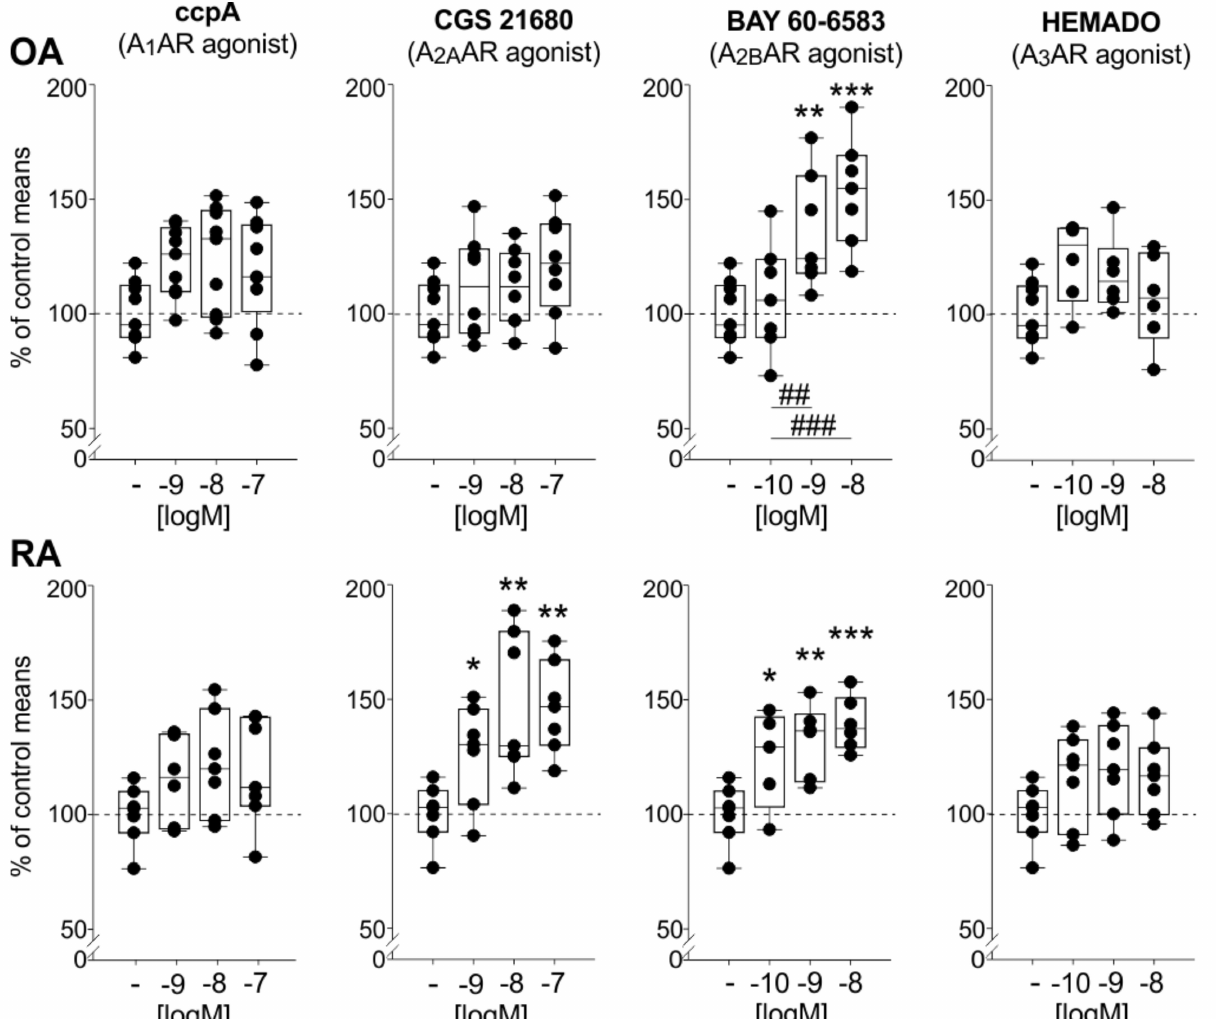
Figure 6. TNF release in OA and RA mixed synoviocyte cultures after activation of individual adenosine receptor subtypes by applying different AR agonists. Data are represented as box plots (as explained in the legend of Figure 1) ( n = 5–6). Values are expressed as percent of untreated control (untreated control is represented as “-“; the mean of untreated controls is represented as dashed line = 100%). Significant p -values compared to untreated control are presented as p * ≤ 0.05. ** p ≤ 0.01. *** p ≤ 0.001 when compared to untreated controls or as ## p ≤ 0.05 ### p ≤ 0.001 when two treatment groups were compared. Abbreviations: see legend to Figure